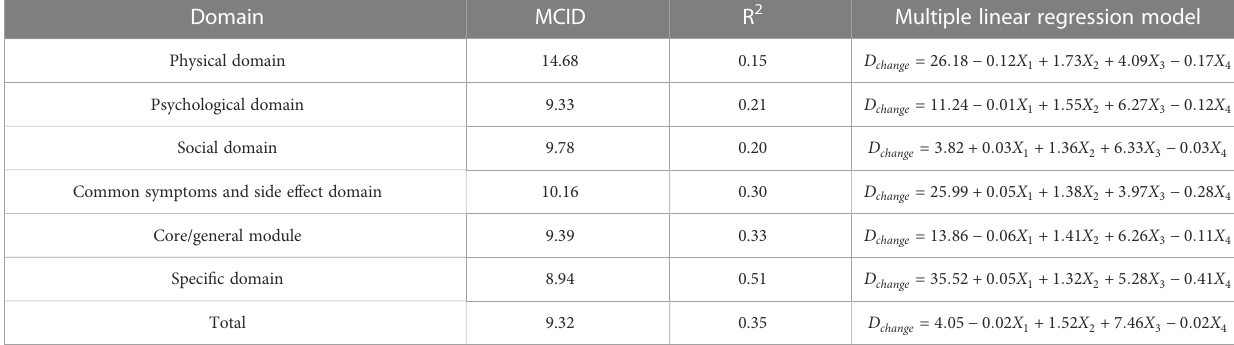
TABLE 6 The MCID of QLICP-BR (V2.0) determined by multiple linear regression models under Standard C ( n C =156). Domain